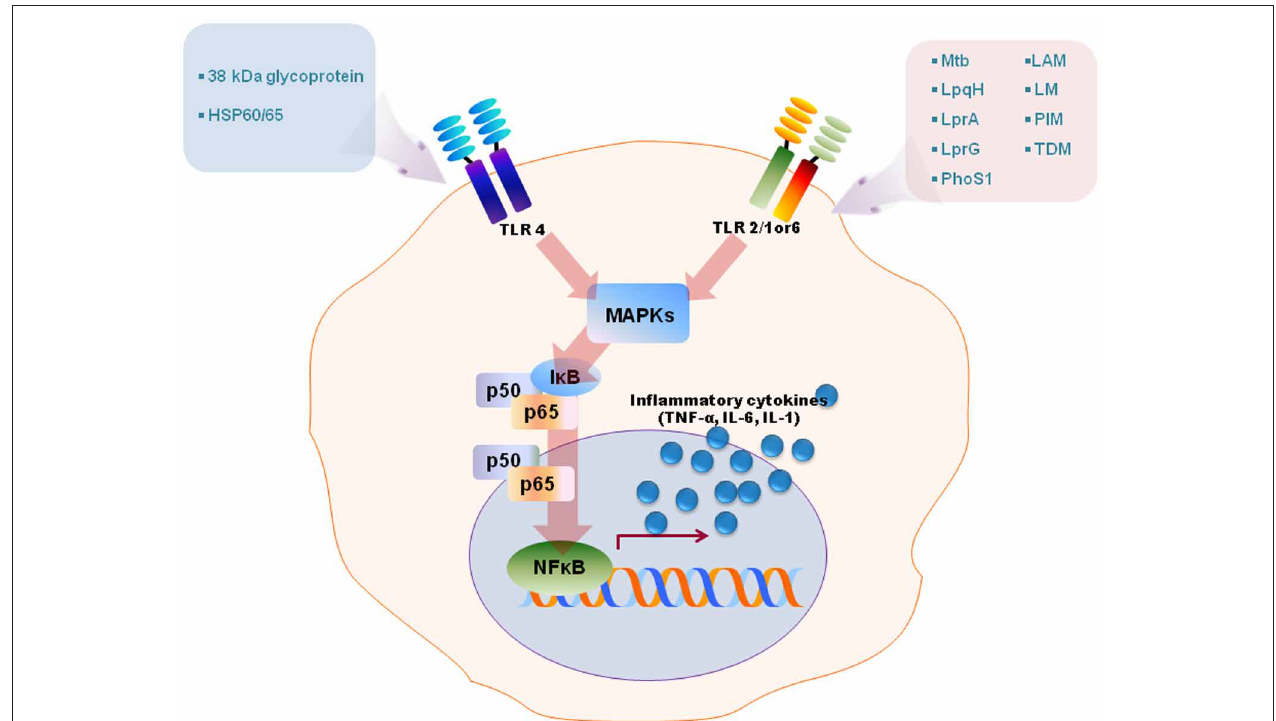
FIGURE 1 | A schematic model for TLRs activation by diverse mycobacterial antigens. TLRs are involved in the innate recognition and responses in innate immune cells to numerous mycobacterial antigens. Some mycobacterial antigens including LpqH, lipoarabinomannan (LAM), lipomannan (LM), 38-kDa antigen, LprG, LprA, PhoS1, trehalose dimycolate